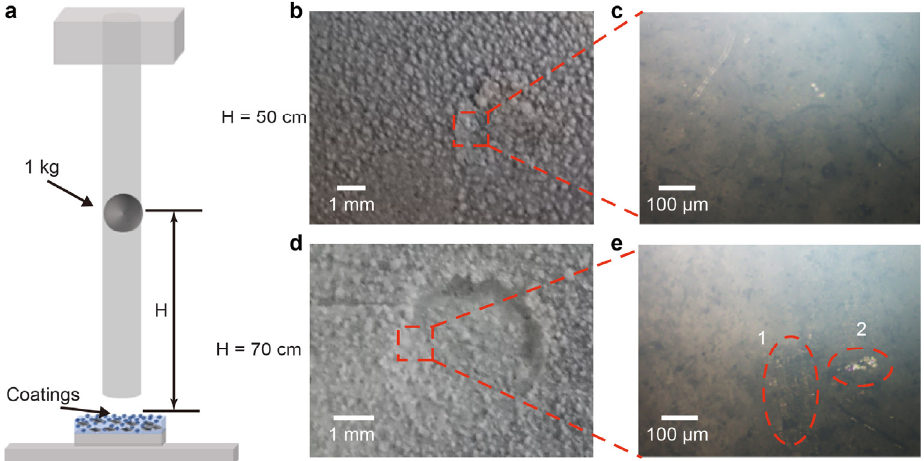
Figure 6. Hammer test showed the excellent impact resistance of the F-SiO 2 /MXene superhydro- phobic coating. ( a ) Schematic of the impact resistance test for the superhydrophobic coatings. ( b , c ) Digital image and optical microscope image of the coating surface after impact testing at a height of 50 cm. ( d , e ) Digital image and optical microscope image of the coating surface after impact testing at a height of 70 cm.